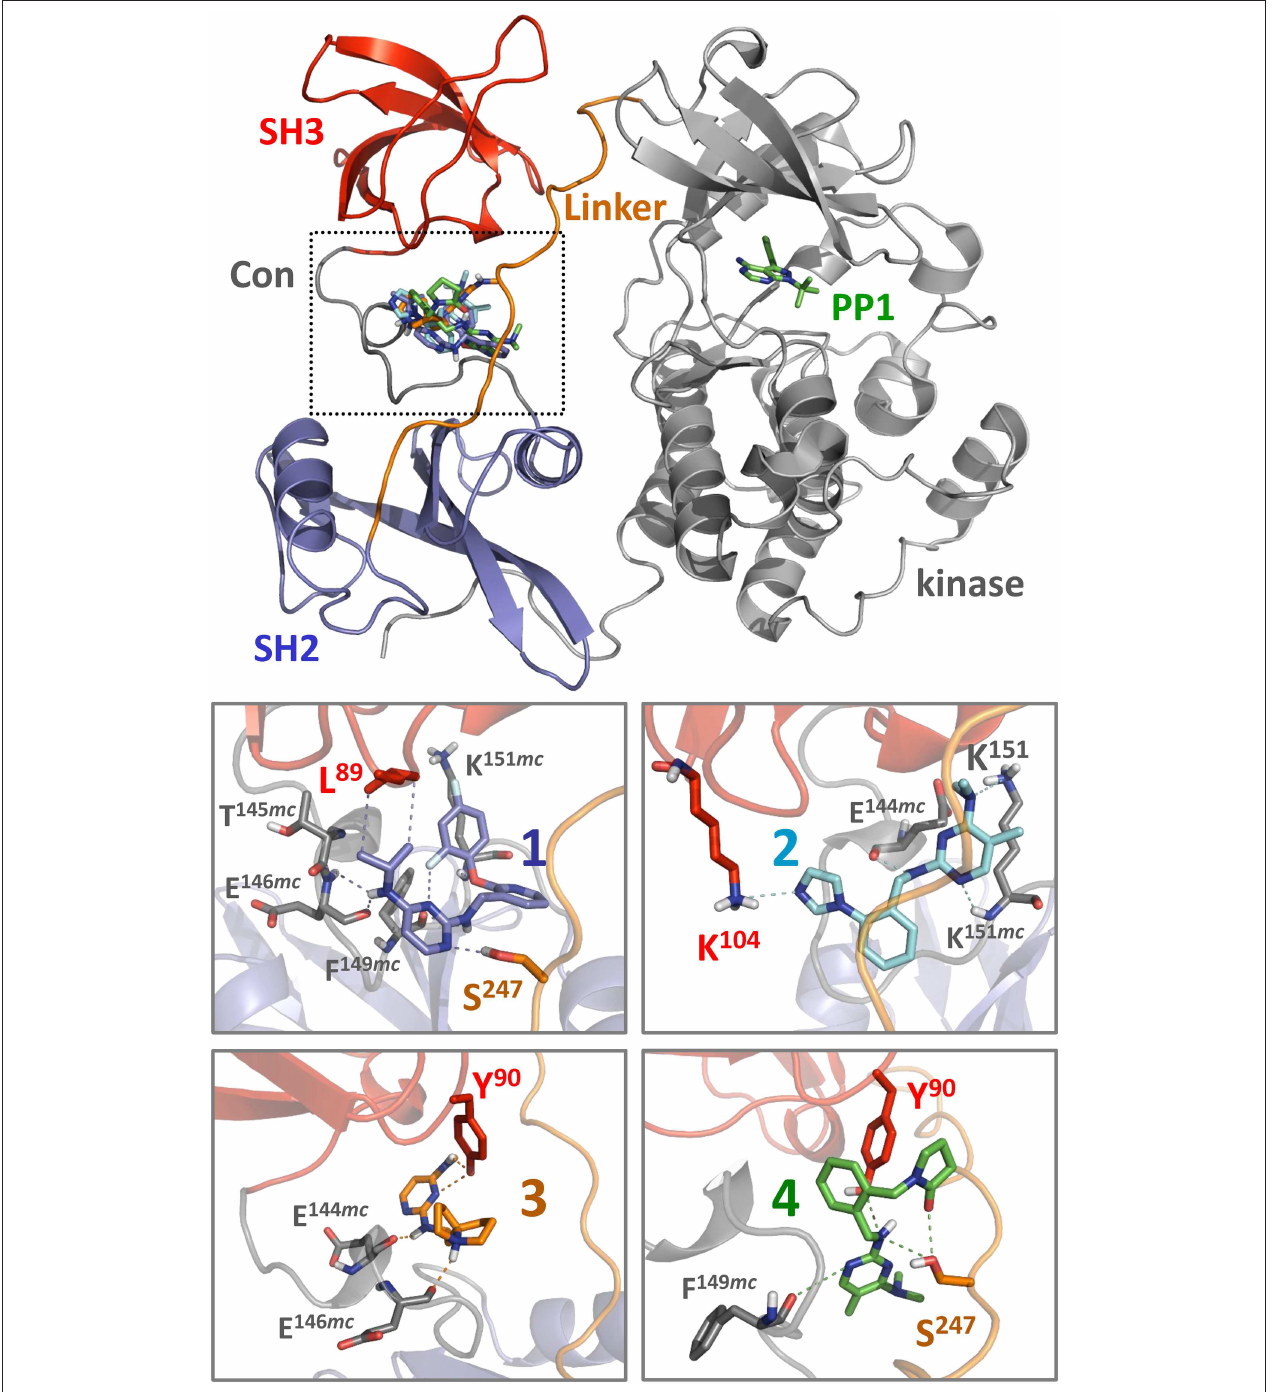
FIGURE 6 | Docking predicts binding of hit compounds to the Hck regulatory region. Compounds 1 through 4 from the Hck-U32L screen ( Figure 4 ) were docked to the crystal structure of near-full-length Hck (PDB: 1QCF) using Smina (Koes et al., 2013). The overall near-full-length Hck structure is shown at the top including the kinase domain, where the ATP-competitive inhibitor PP1 marks the active site. All four compounds are predicted to bind within a pocket formed by the convergence of the SH3 domain, the SH3-SH2 connector ( Con) , and the SH2-kinase linker (boxed region). Close-up views of binding sites for compounds 1 through 4 (lower panels) show predicted interatomic contacts between the ligand and side/main chain residues ≤ 4 Å ( dotted lines ). Side chains and main chains ( mc ) predicted to participate in ligand binding are labeled. Nitrogen atoms present in the pyrimidine diamine core found in all four compounds make multiple contacts with the target protein. Compound 2 is unique among the four compounds, in that it makes predicted polar contacts with the side chain of SH3 Lys104 and the side and main chains of linker Lys151. This observation may relate to its greater stimulatory activity in the kinase activity assay compared to the other three compounds ( Figure 7 ).